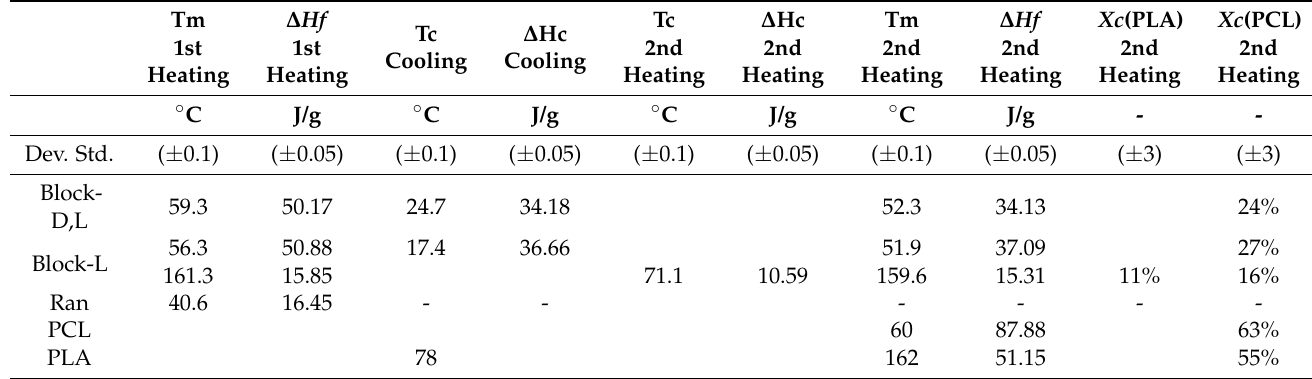
Table 3. Thermal properties of the analyzed